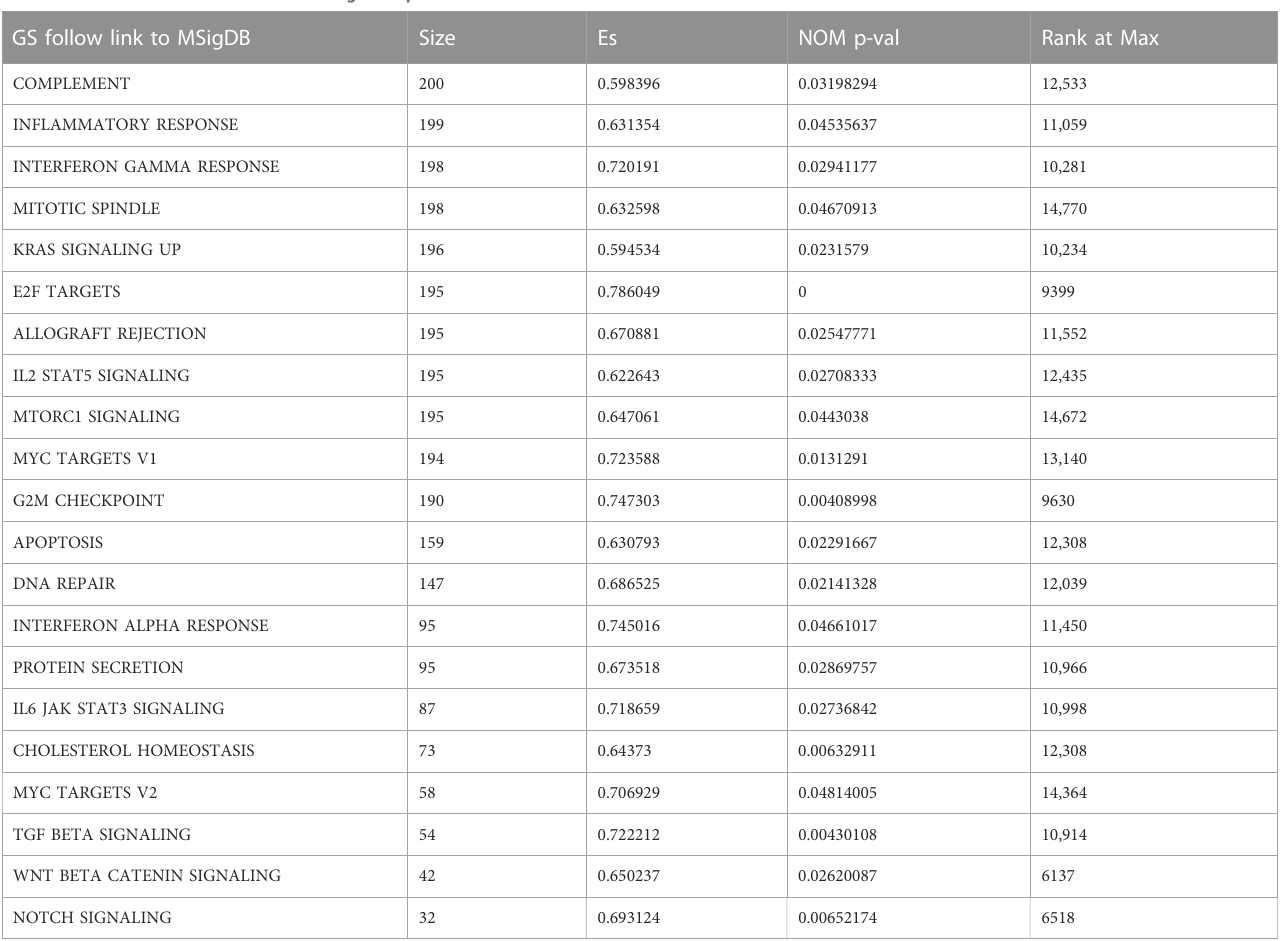
TABLE 1 Gene sets enriched in normal and glioma patients. GS follow link to